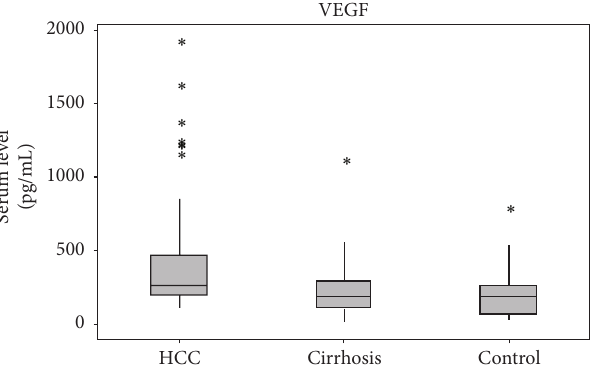
Figure 2: Box-plot representation of median and quartile values of serum vascular endothelial growth factor (VEGF) levels. HCC: median = 264.8, minimum = 102.0, maximum = 1795.1, Q1 = 199.4, Q3 = 467.7, and IQRange = 268.3; cirrhosis: median = 182.8, minimum = 7.2, maximum = 993.0, Q1 = 103.9, Q3 = 287.4, and IQRange = 183.5; control : median = 182.2, minimum = 31.6, maximum = 666.1, Q1 = 66.14, Q3 = 265.5, and IQRange = 199.4. ∗ Extreme outliers of the distribution of serum levels values. Extreme outliers are observations that are beyond one of the outer fence OF1 or OF2. The outer fences are calculated as follows: OF 1 = Q 1 − 3 ∗ IQR , OF 2 = Q 3 + 3 ∗